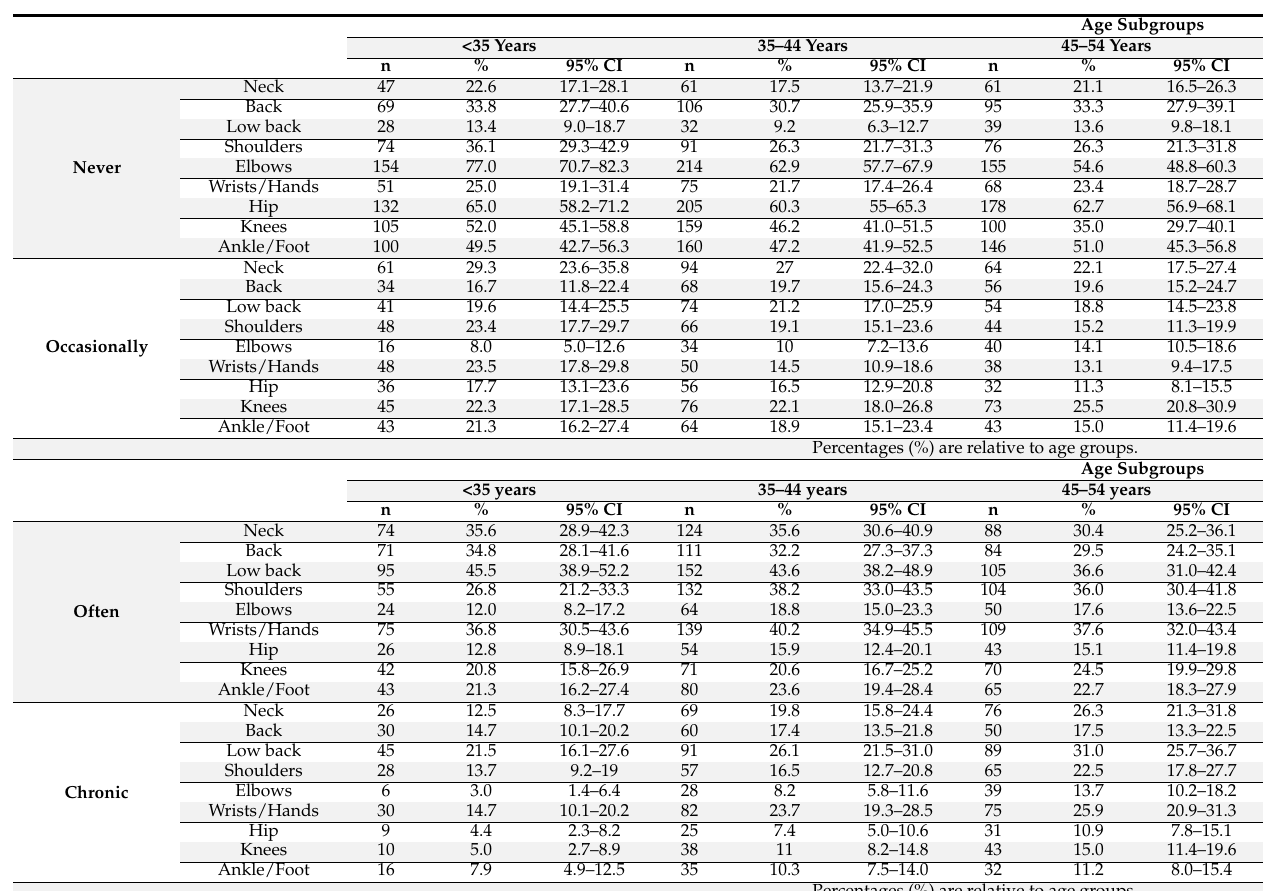
Table A1. Bivariate analysis of pain by body regions and age subgroups ( n =